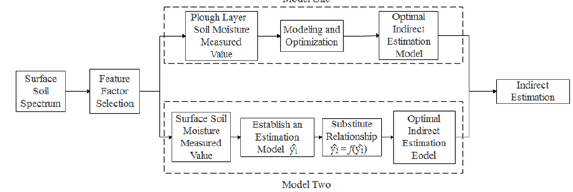
Figure 2. Two models of indirect estimation